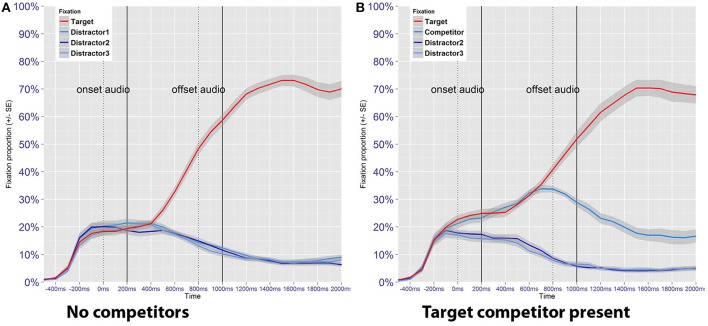
Proportion of fixations toward the target image as a function of time, plotted separately for no competitor trials (A) and target competitor trials (B). Blue lines represent fixation proportions toward the three distractor images, which in (B) features a target competitor. Dotted lines represent approximate acoustic onsets and offsets for the auditory stimuli, while the solid lines include a 200 ms shift to account for the temporal lag between language processing and eye movement execution.